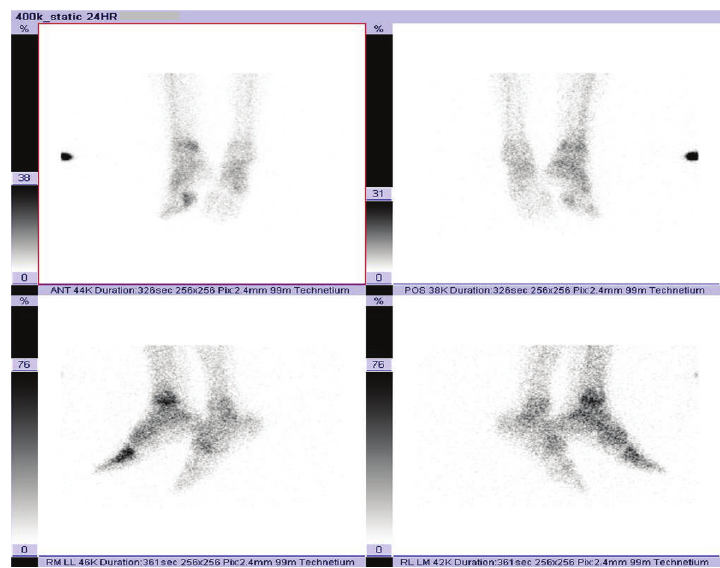
Figure 3: Three-phase bone scan was performed, with attention to the ankles and feet (33 mCi Tc-99 m MDP injected IV). The images demonstrate areas of increased delivery of tracer at the right distal lower extremity and around MTP I on bone phase.